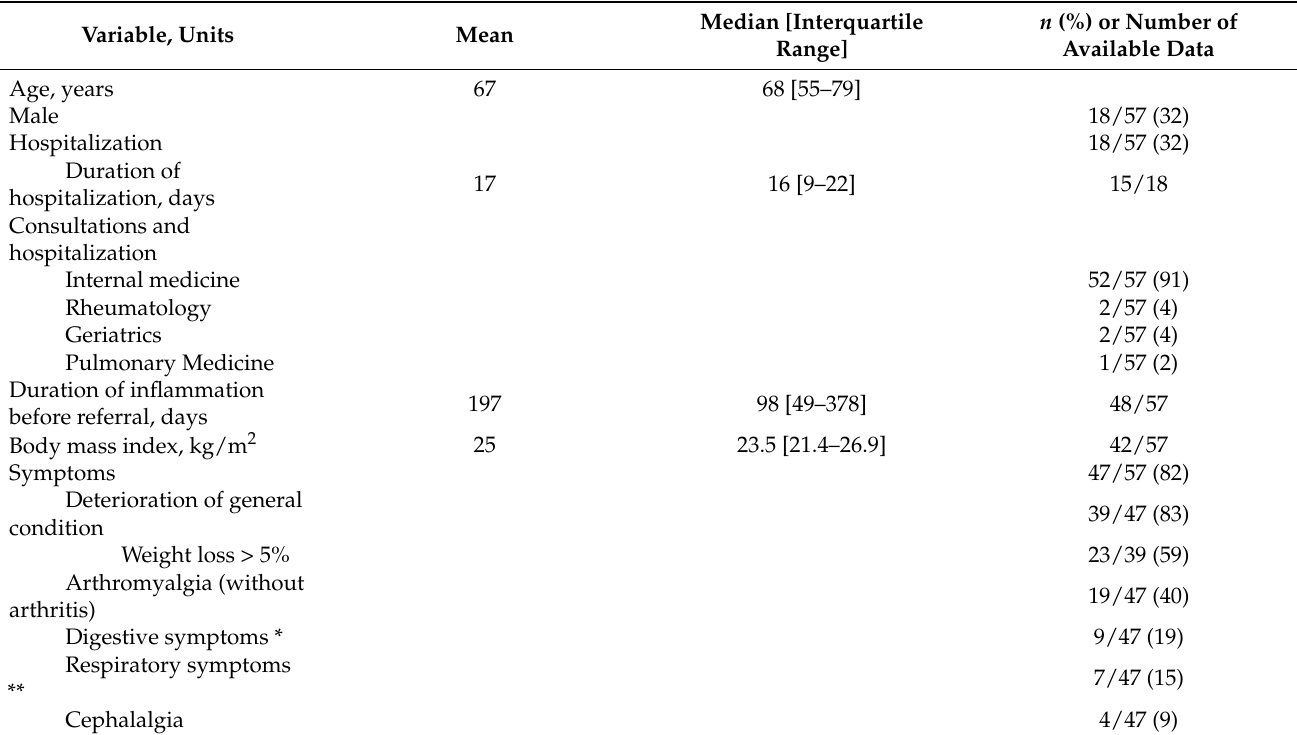
Table 1. Demographic and clinical variables.